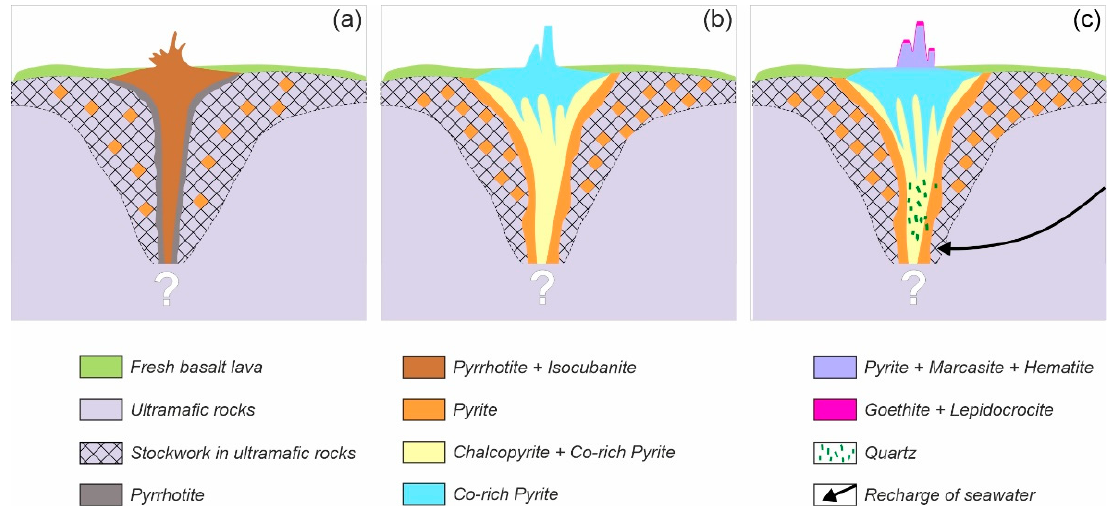
Figure 19. Reconstruction model for massive sulfide formation in the Semenov-5 hydrothermal field. ( a ) Sub-seafloor formation of pyrrhotite and pyrrhotite-isocubanite as a major sulfide channel by replacement of ultramafic host rock; seafloor massive sulfides are also represented by relict pyrrhotite and isocubanite. ( b ) Replacement of pyrrhotite and isocubanite by pyrite, chalcopyrite and